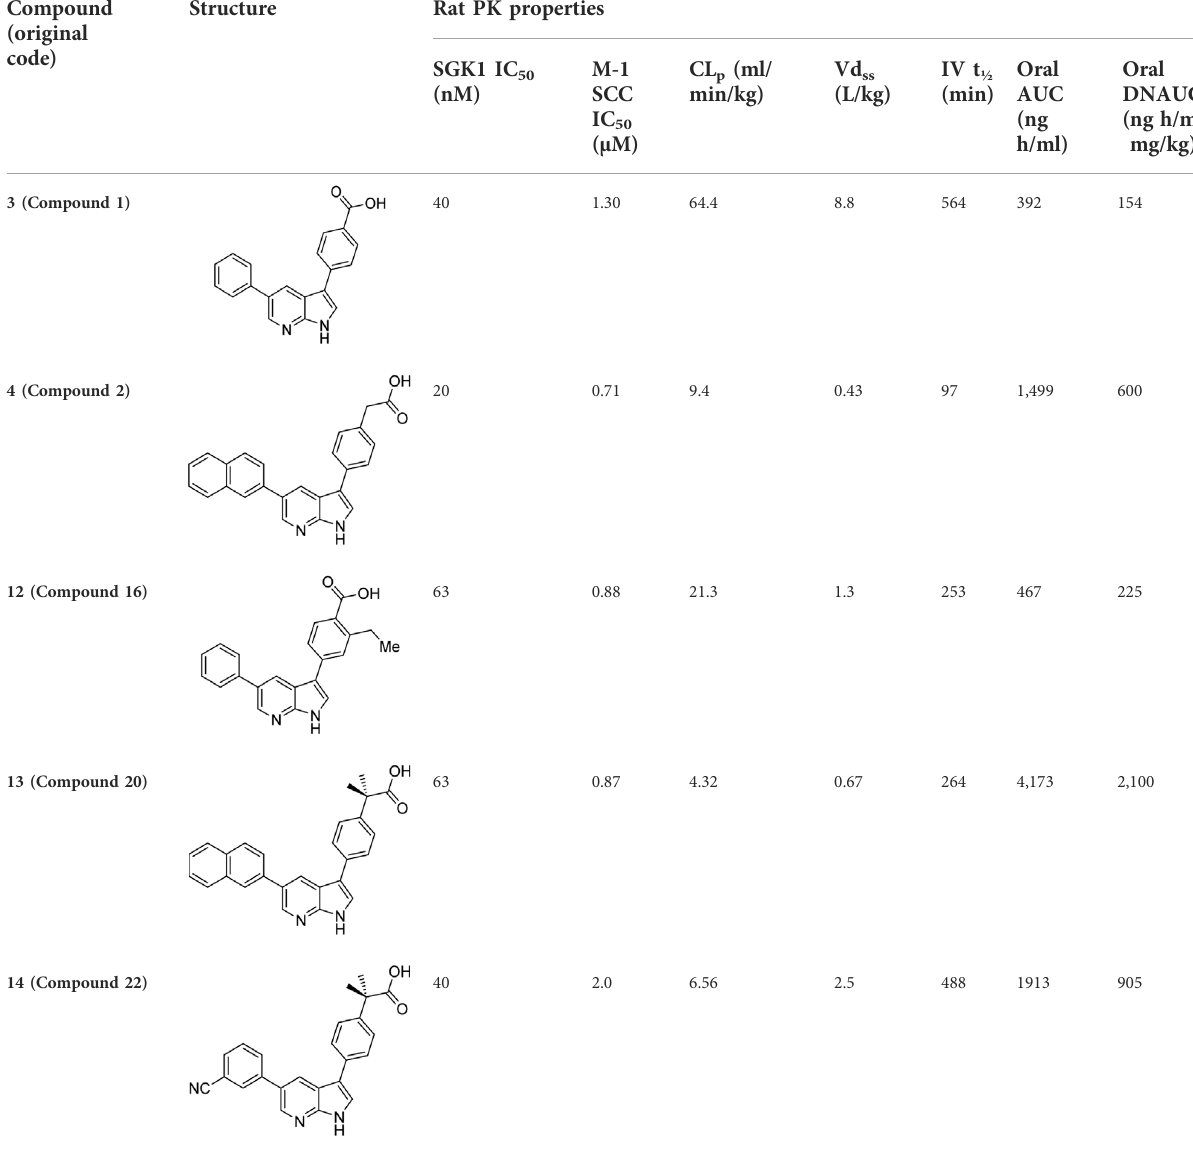
TABLE 2 In vitro SGK1 inhibition and rat PK properties of compounds 1, 2, and their analogs (Hammond et al.,